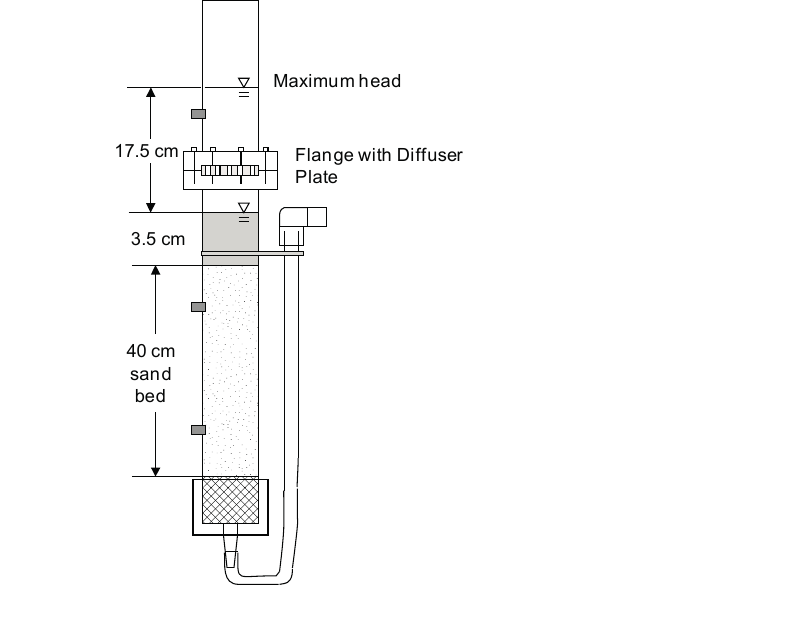
Figure 1. Cross-section of bench-scale columns used in Column Test No. 1. Six columns